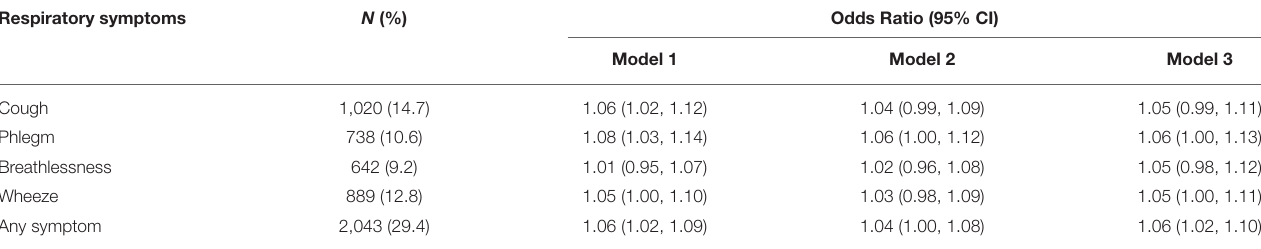
TABLE 3 | Association of log RCS with respiratory